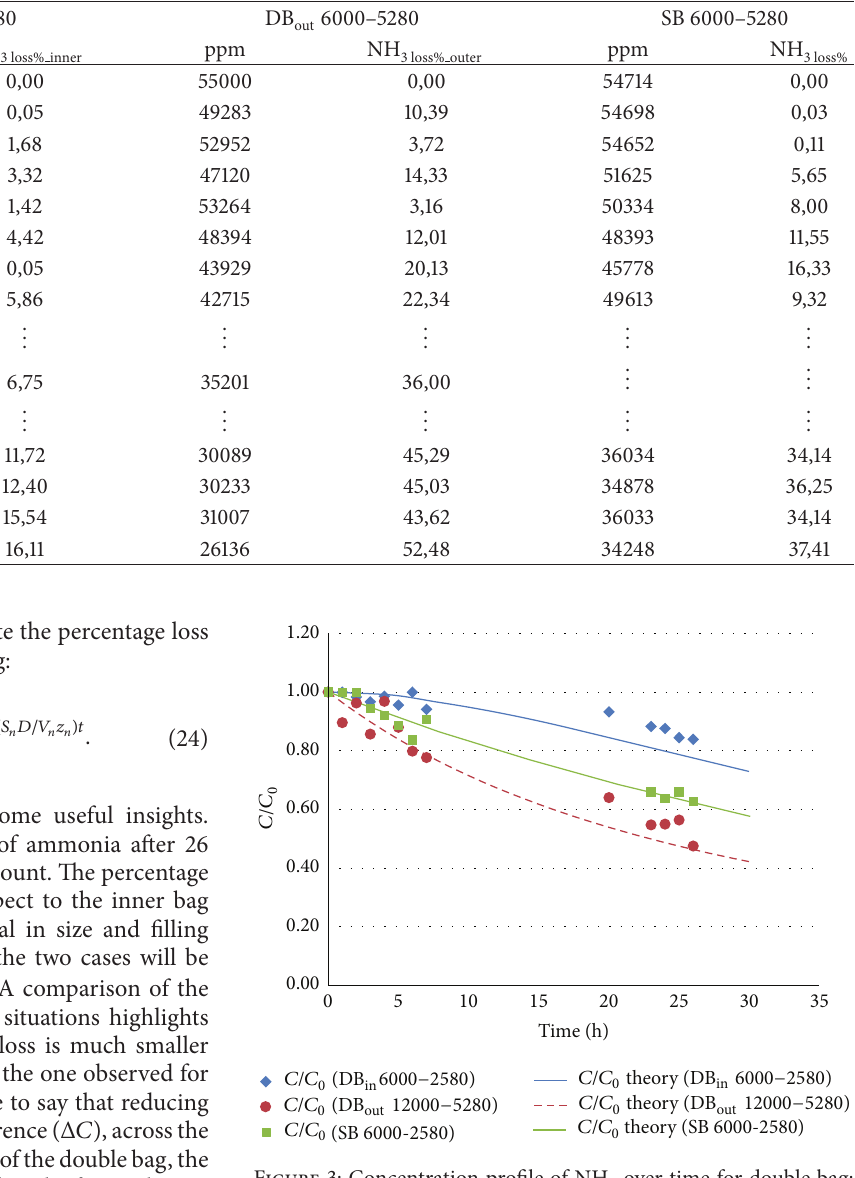
Figure 3: Concentration profile of NH 3 over time for double bag: experimental data (dots) versus theoretical trend (continuous